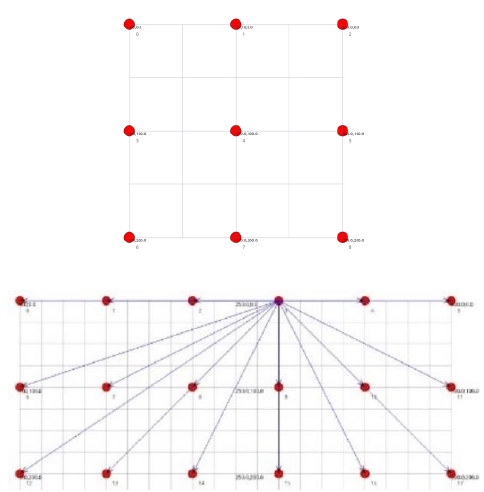
Figure 1. The 3x3 and 6x3 Network Topologies on the top and bottom panels,